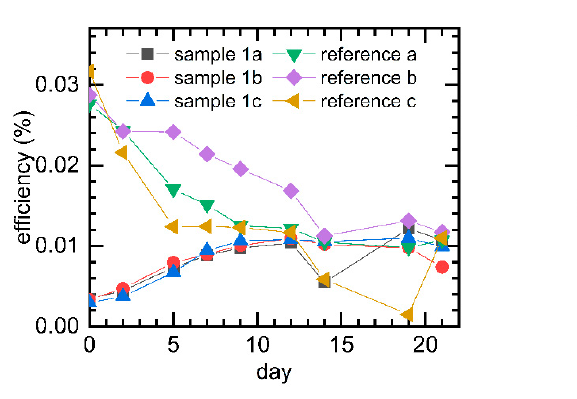
Table 2. Ionic conductivities of the investigated GPEs. The sample number refers to Table